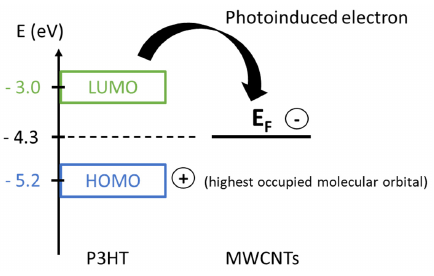
Figure 2. Energy-band diagrams of P3HT and MWNTs (adapted from [20]). (Reprinted (adapted) with permission